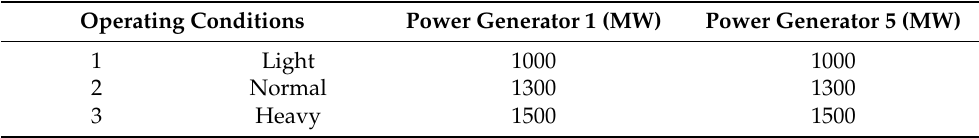
Table 10. The summary of operating conditions of IEEE 50-Machine Power System.